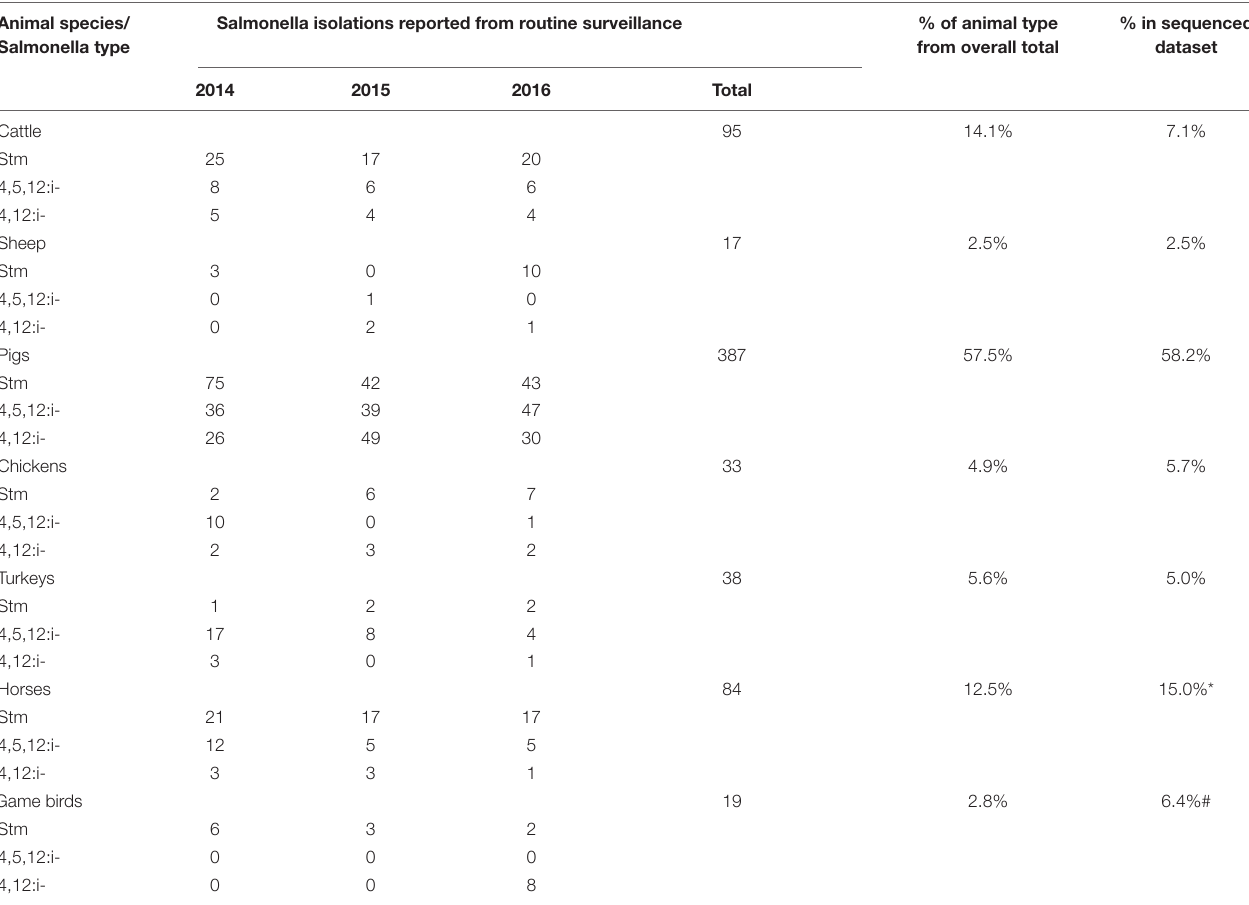
TABLE 2 | Comparison of the distribution of Salmonella Typhimurium and monophasic variants in different in animal sources from routine surveillance and those selected for whole genome sequencing. Animal species/ Salmonella